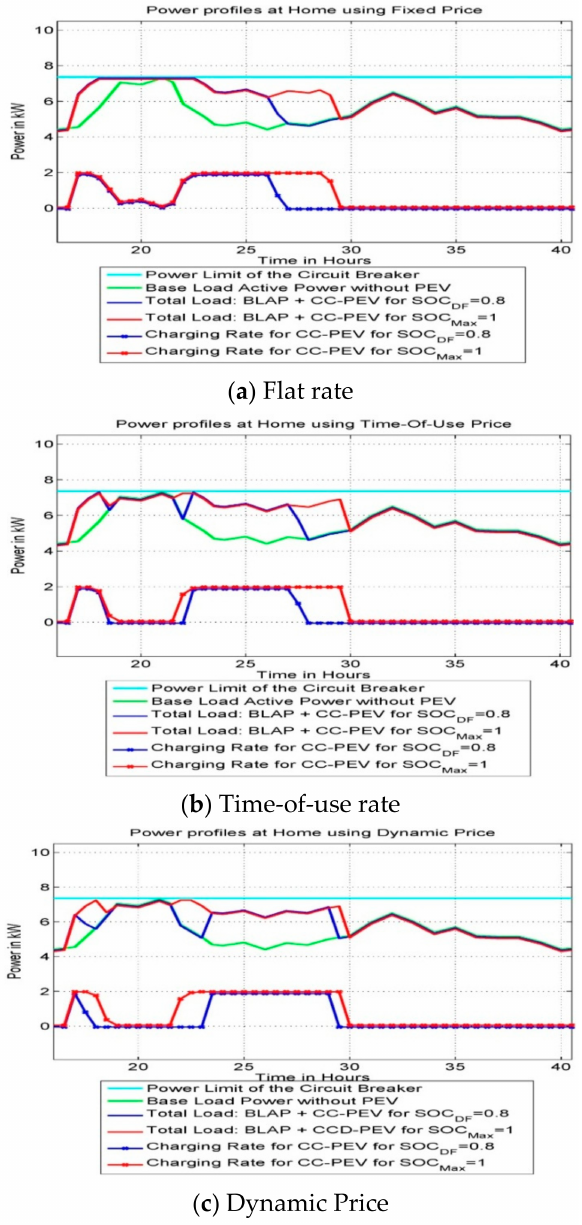
Figure 4. Power profiles for SOC Max = 1 and SOC D = 0.8, for ( a ) Flat rate, ( b ) TOU, ( c ) Dynamic